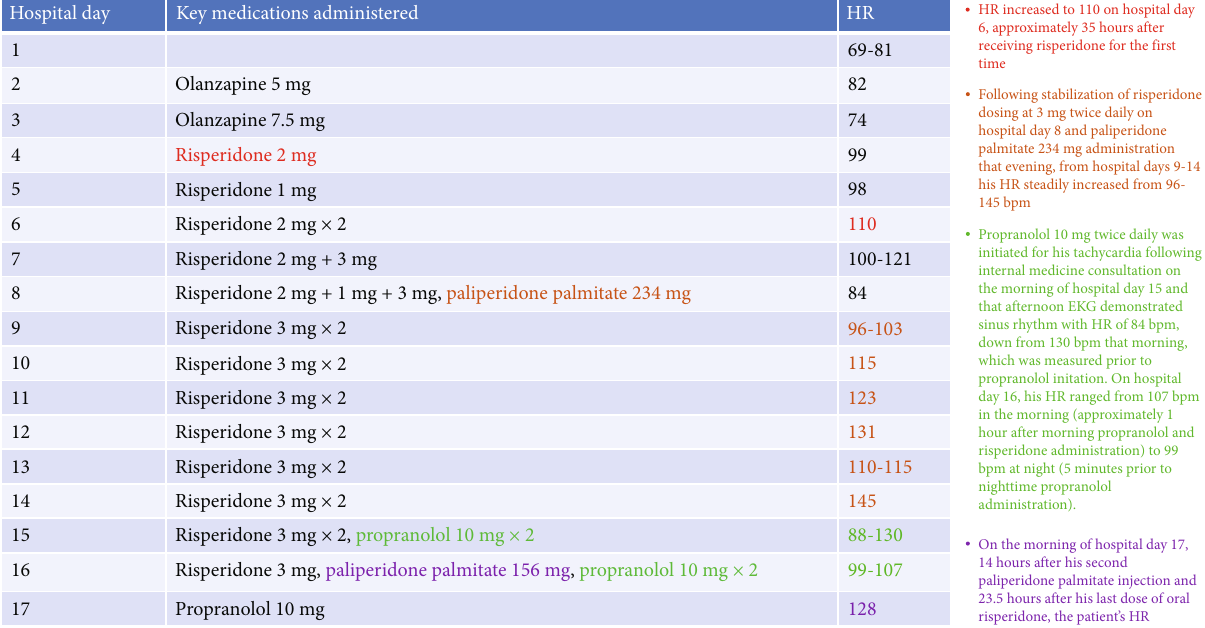
Figure 3: Hospital course